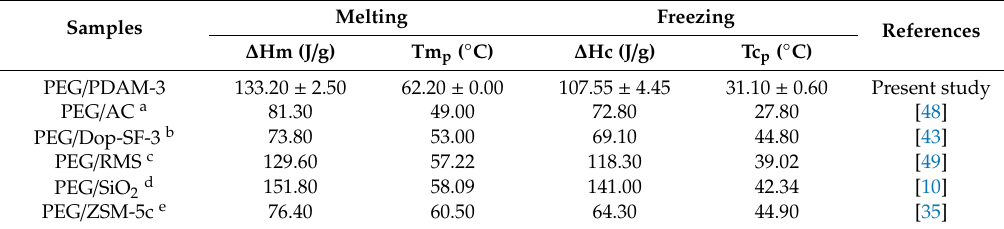
Table 2. Comparison of PEG/PDAM-3 with other composite materials.